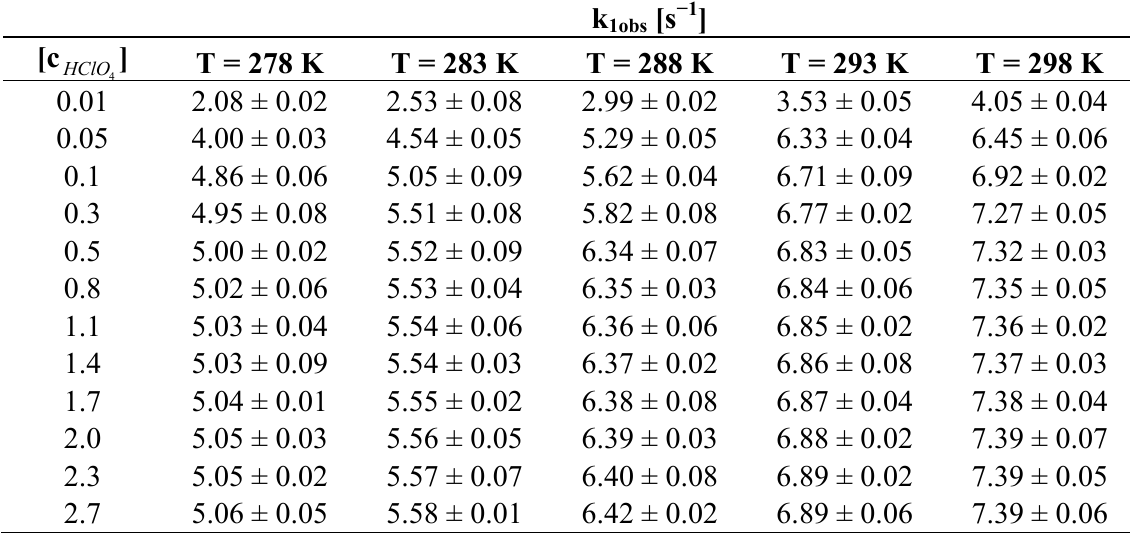
Table 4. Relationship between the pseudo-first-order rate constants (k cation concentration for the acid-catalyzed hydrolysis of the cis -[Cr(C complex anion.